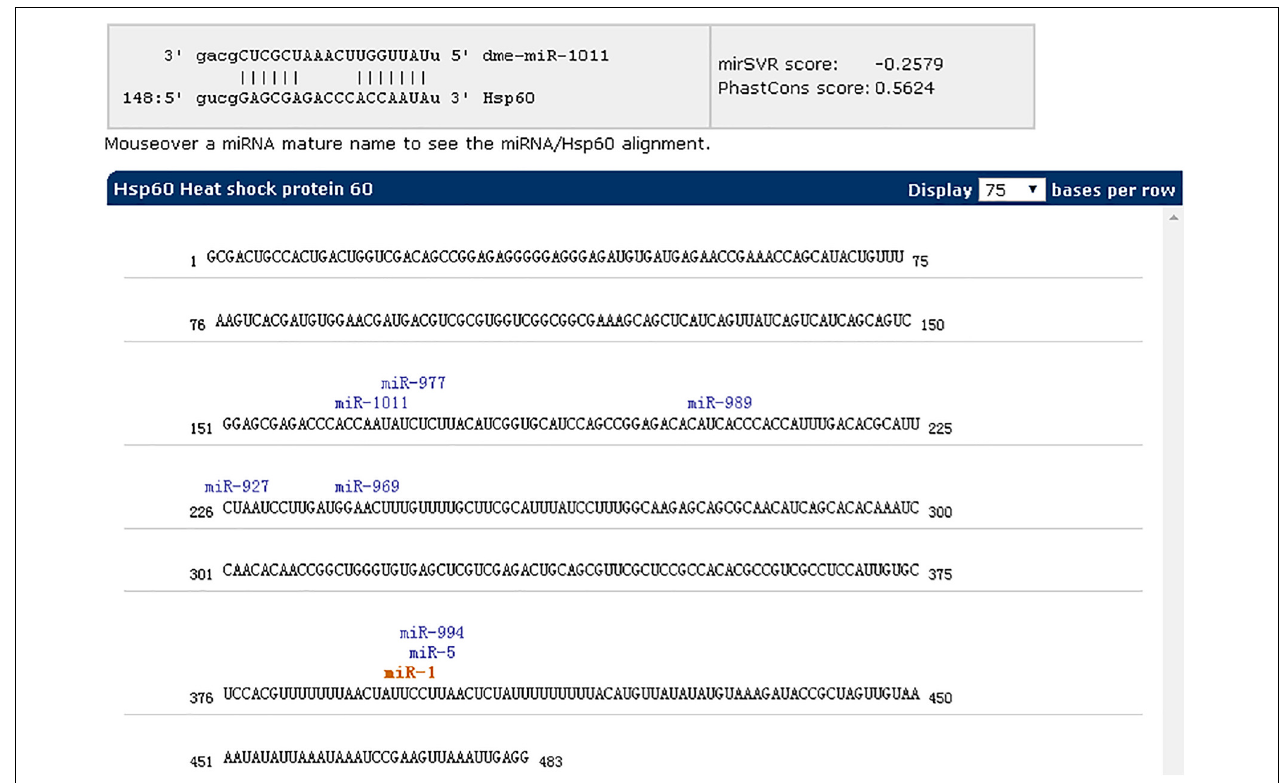
FIGURE 11 | miR-1 inhibition as the model strain and Hsp60 as the target gene for microRNA cluster prediction using miRWalk (version 3.0).